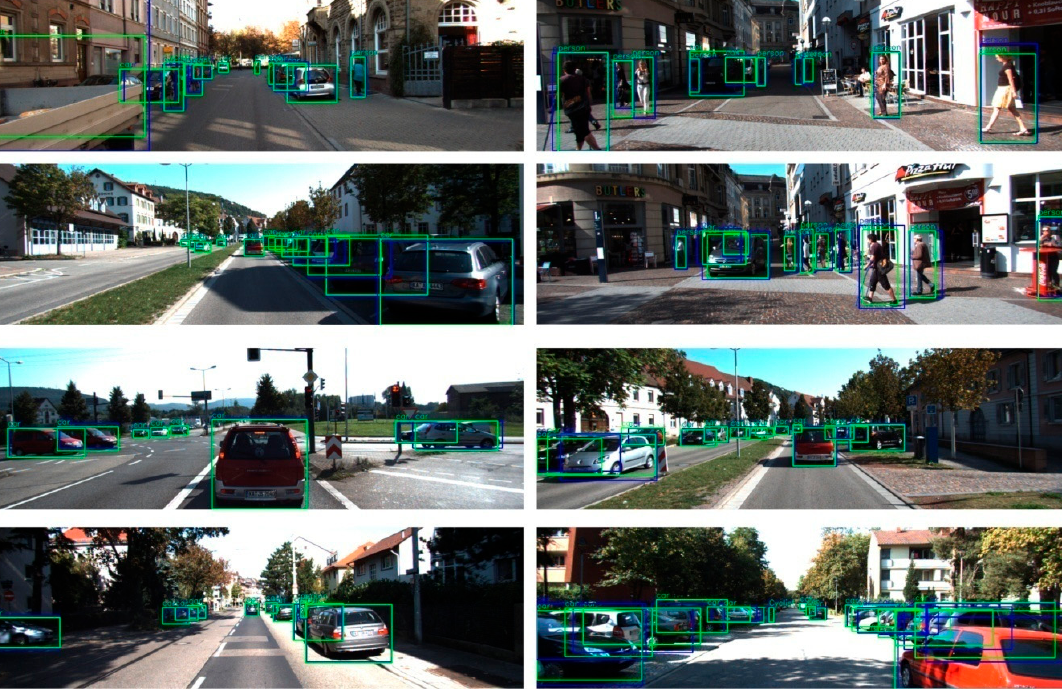
Figure 8. Results of improved YOLO V3 on the KITTI dataset.